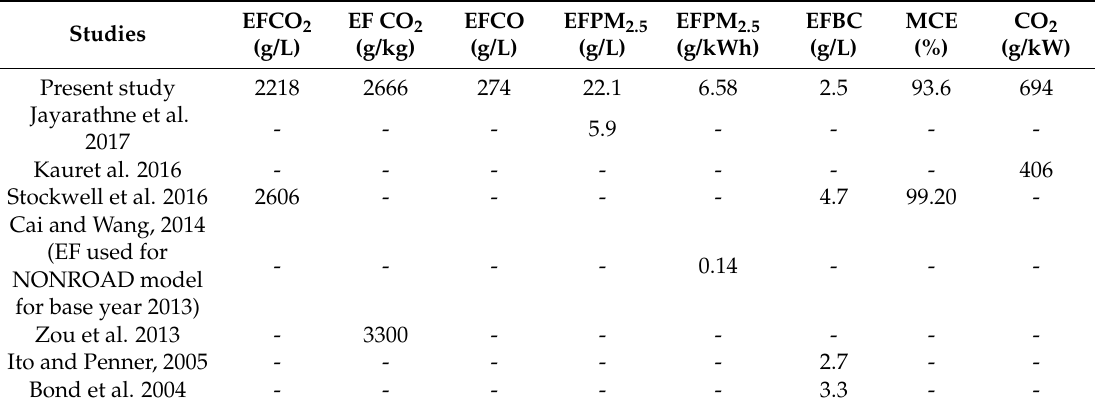
Table 3. Comparison of emission factors with previous